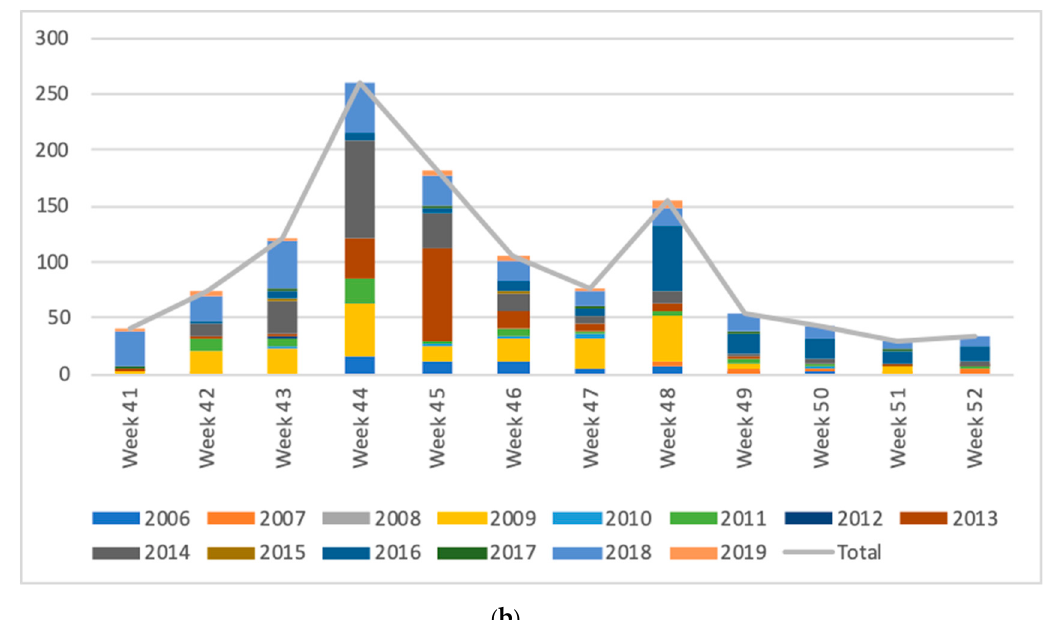
Figure 3. ( a ). Spring cases: weekly occurrence of atypical myopathy cases from week 9 (1 March) up to week 20 (31 May) over the study period (2006–2019); ( b ). Autumnal cases: weekly occurrence of atypical myopathy cases from week 41 (1 October) up to week 52 (31 December) over the study period (2006–2019).